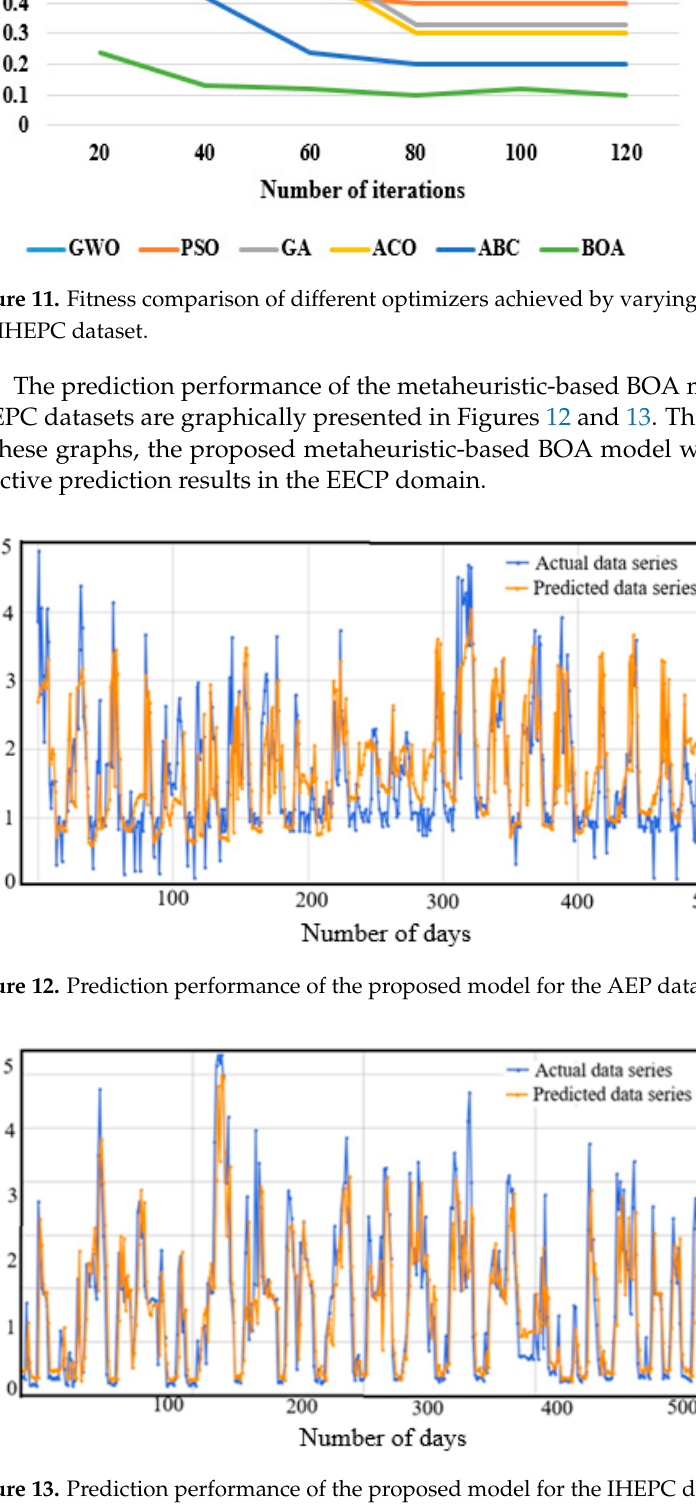
Figure 10. Graphical presentation of the dissimilar hyperparameter optimizers in the LSTM network on the IHEPC dataset.